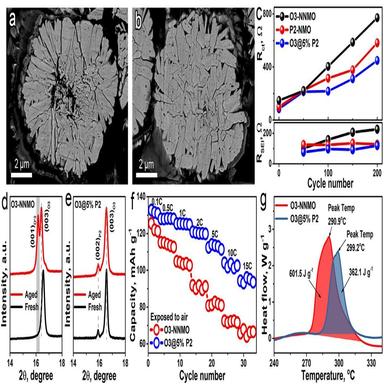
The chemical and thermal stabilities of prepared cathodes. Cross-sectional SEM images of (a) O3-NNMO and (b) O3@5% P2 cathodes after 200 cycles. (c) Charge transfer resistance and SEI resistance as a function of cycle number. XRD patterns of (d) O3-NNMO and (e) O3@5% P2 after exposure to air (with a relative humidity of 55%) for 3 days. (f) Rate capabilities of the aged cathodes. (g) DSC profiles of desodiated cathodes.